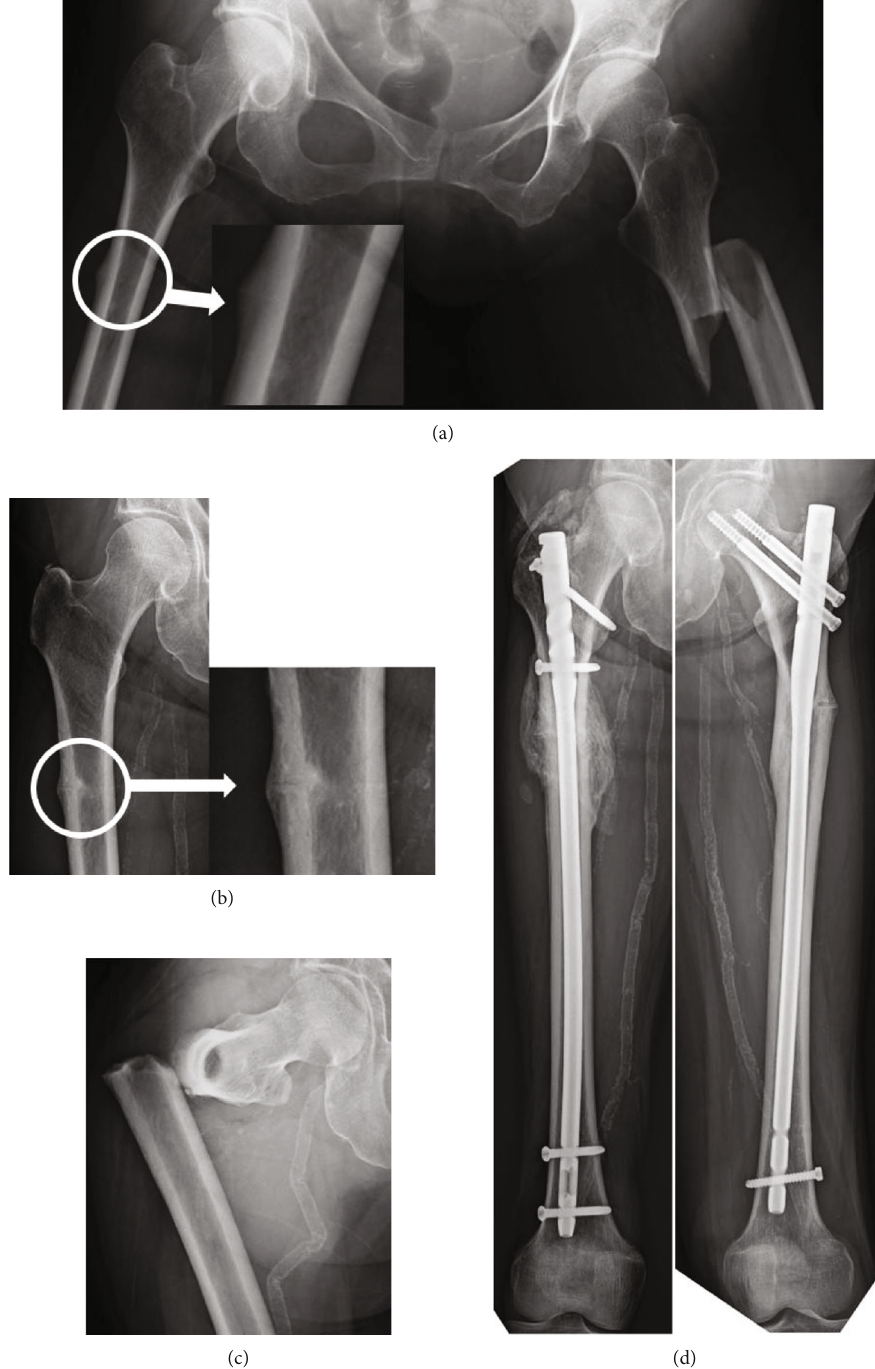
Figure 3: (a) The patient su ff ered a subtrochanteric AFF on the left side by sprain. At that time, the right femoral roentgenogram showed periosteal thickening of the lateral cortex at the subtrochanter (circle; see magni fi cation). (b) Periosteal thickening of the lateral cortex progressed to incomplete fracture (circle; see magni fi cation). (c) Incomplete fracture progressed to complete fracture by falling. (d) Complete bone unions were achieved on the left and right sides at 58 and 25 months after the surgery,